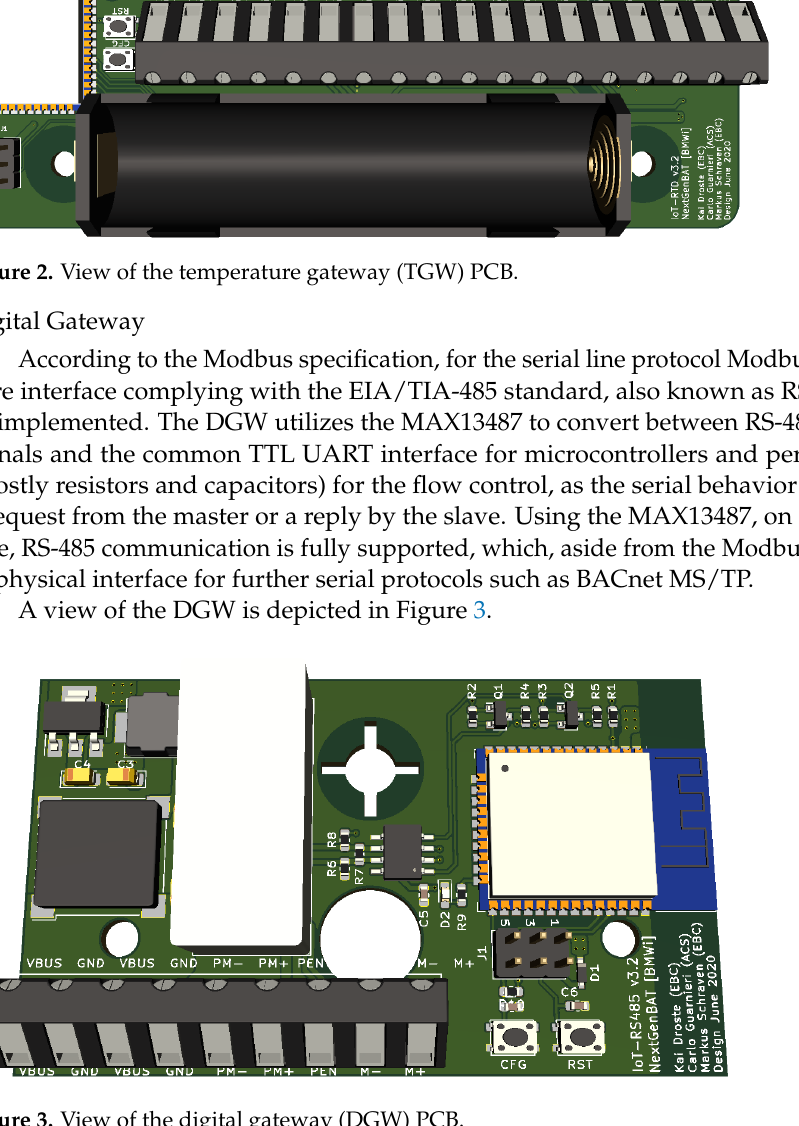
Figure 3. View of the digital gateway (DGW)